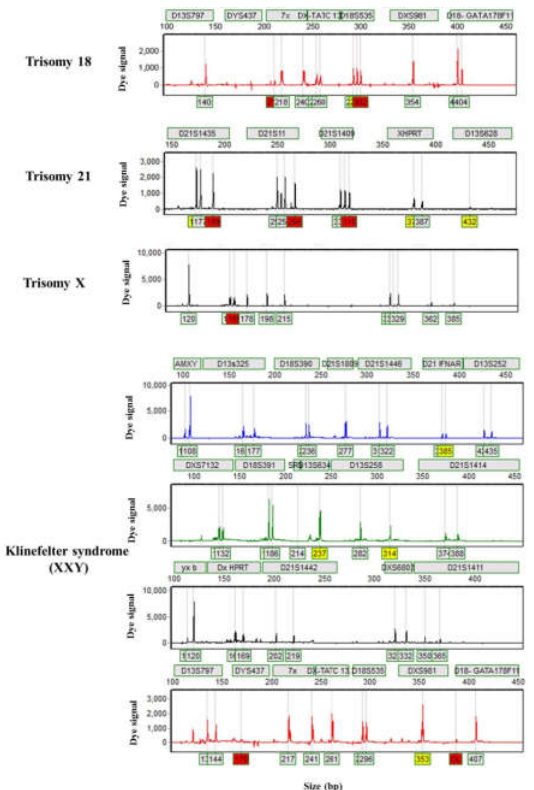
Fig. 1. Multiplex QF-PCR assays with STR markers in DNA samples of aborted fetuses: In the trisomy 18 sample, D18S535 shows a triallelic pattern with a dosage ratio of 1:1:1, and GATA178F11 shows a 2:1 pattern. The sample with trisomy 21, D21S1435, D21S11, and D21S1409 show a triallelic pattern with a dosage ratio of 1:1:1. In the trisomy X sample, DxHPRT and DXS6803 show a triallelic pattern with a dosage ratio of 1:1:1. In the sample with Klinefelter syndrome (XXY), AMXY shows a 1:2 pattern, DXS7132 shows diallelic with a dosage ratio of 1:1, Y/XB3 shows a trisomic pattern with a dosage ratio of 2:1, DxHPRT shows a diallelic pattern with a dosage ratio of 1:1, DXS6803 shows a diallelic pattern with a dosage ratio of 1:1, 7X marker shows a diallelic pattern with a dosage ratio of 1:1, and DX- TATC13.35 shows a diallelic pattern with a dosage ratio of